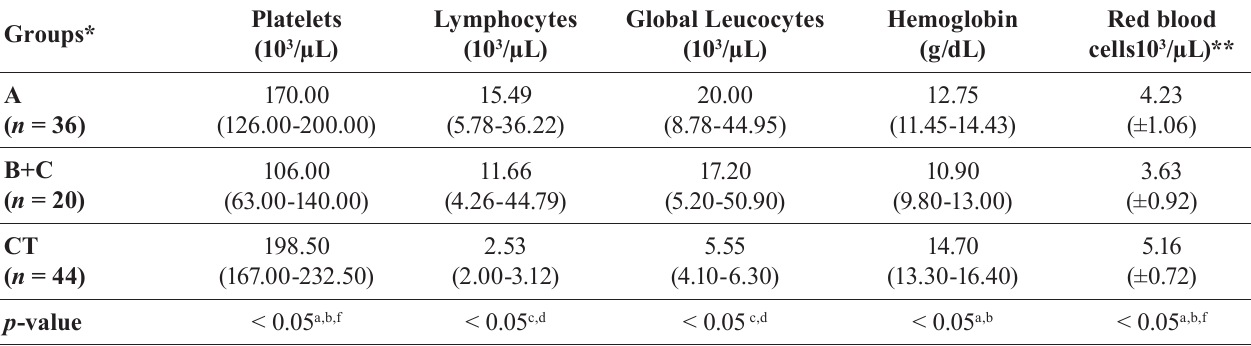
TABLE III - Characterization of patients according to Binet staging